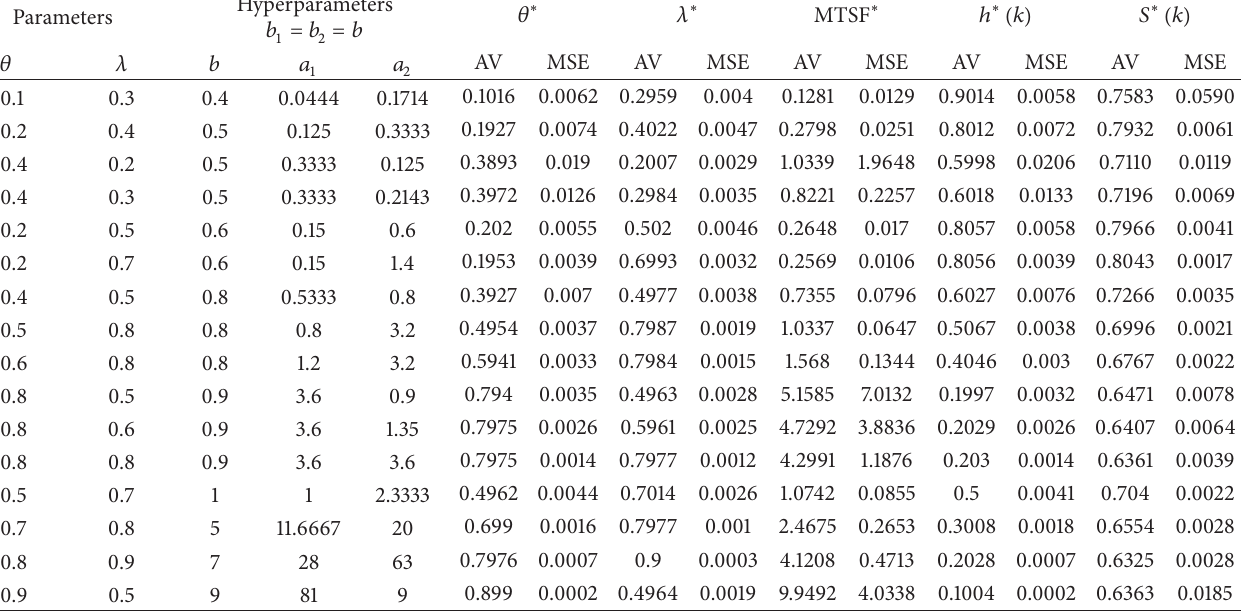
Table 5: Bayes estimates under